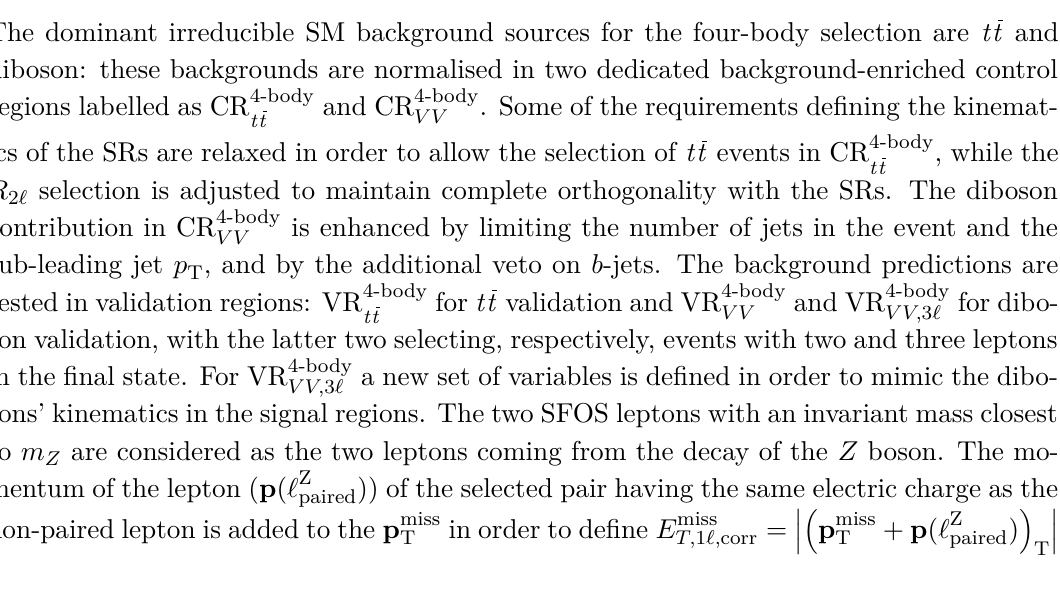
Figure 4 . Three-body selection. Distributions of (a) ∆ φ R the CR 3-body